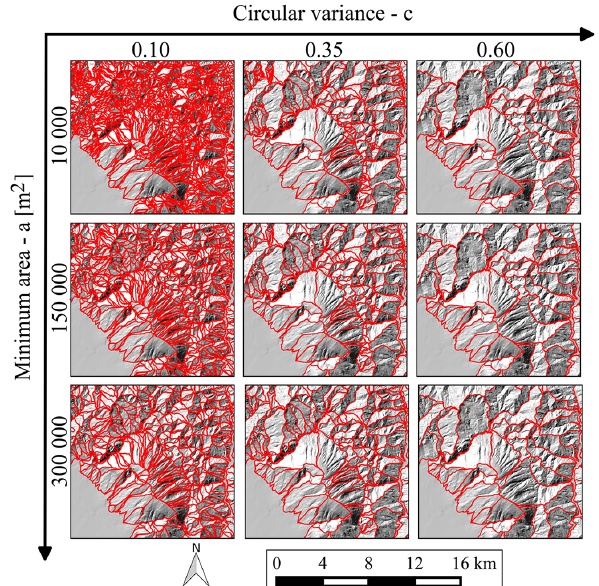
Figure 6. A group of 9 (out of 99) SU terrain subdivisions for a portion of the study area. The SUs were obtained changing the a and c parameters used by the r.slopeunit software. The maps are in the UTM zone 32, datum ED50 (EPSG:23032) reference system.